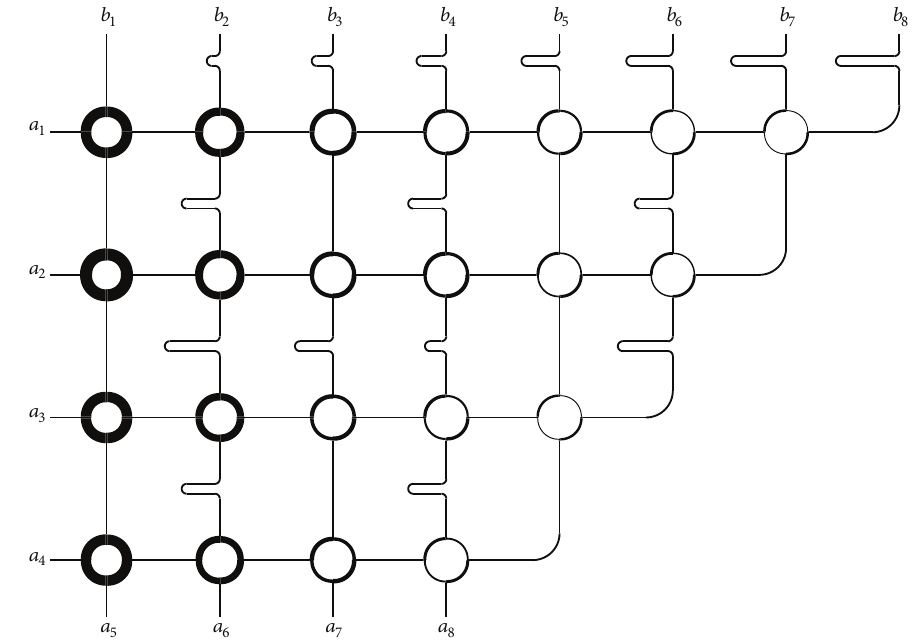
Figure 6: Layout of a 4 × 8 Nolen matrix with tapered amplitude